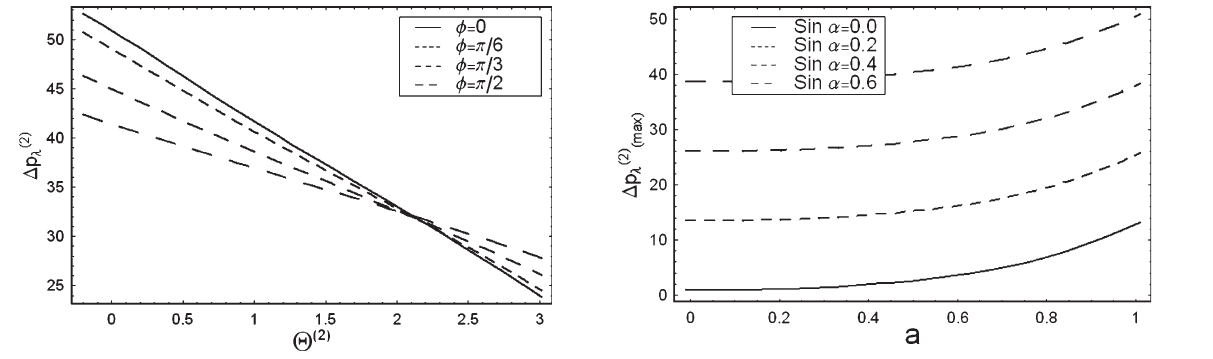
Fig. 9. Effect of inclined angle α on variation of (cid:16)p (2) with θ (2) for λ θ = 0 . 0001, b = 0 . 4, d = 1, Re = 10, (cid:15) = 0 . 02, Fr = 1, β = 0 . 1 and φ = π/ 2.